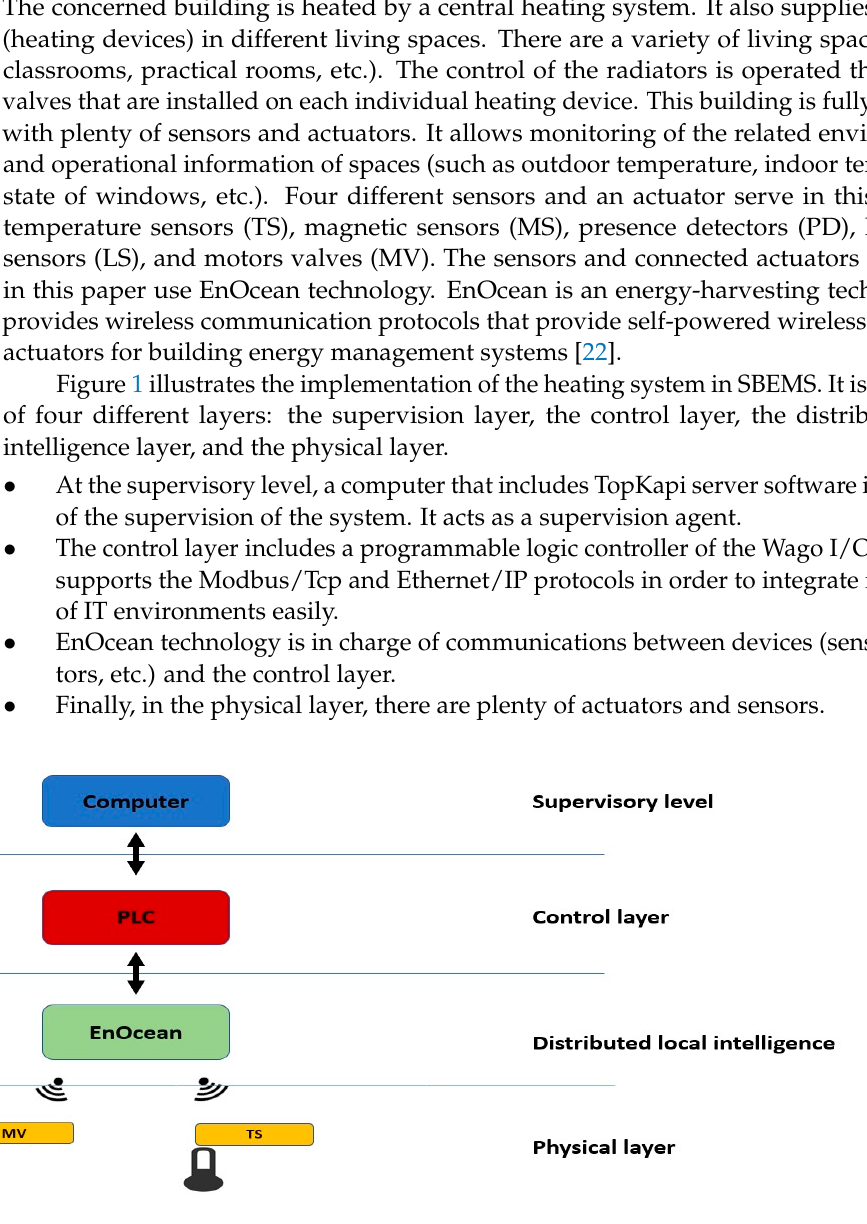
Figure 1. Implementation diagram of the heating system in building A of the Senart Campus of Université Paris Est Créteil (UPEC). PLC: programmable logic controller, MV: motor valve, TS: temperature sensor.